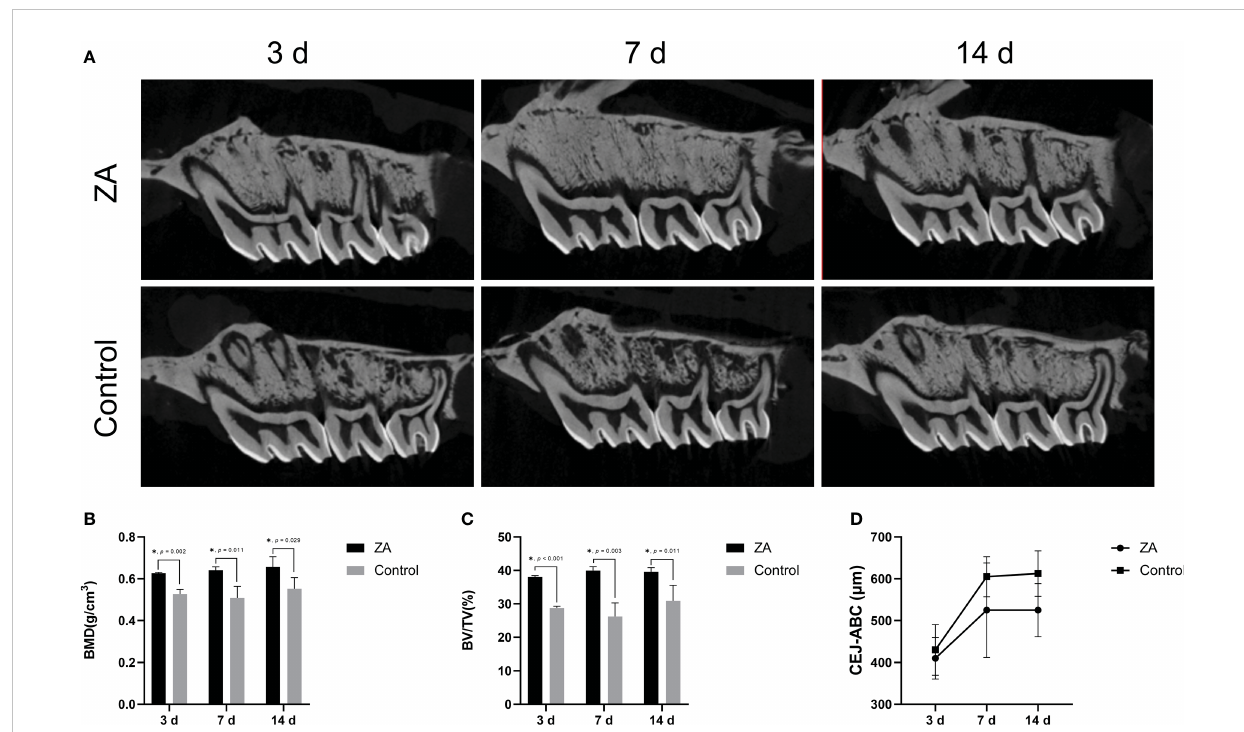
FIGURE 4 Micro-CT analysis showed bone morphology parameters of the ZA group and the control group. (A) Representative micro-CT sagittal images of maxillary alveolar bone surrounding the fi rst and second molars on days 3, 7, and 14. The ZA group showed higher bone density and less alveolar bone resorption than the control group. ( B ) The bone mineral density (BMD) of maxillary alveolar bone surrounding the second molars on days 3, 7, and 14. n = 4 at each time point. (C) The bone volume per total volume (BV/TV) of maxillary alveolar bone surrounding the second molars on days 3, 7, and 14. n = 4 at each time point. (D) The distances between the cemento-enamel junction and alveolar bone crest (CEJ-ABC) of maxillary alveolar bone surrounding the second molars on days 3, 7, and 14. n = 4 at each time point. Values represent mean ± SD. *p